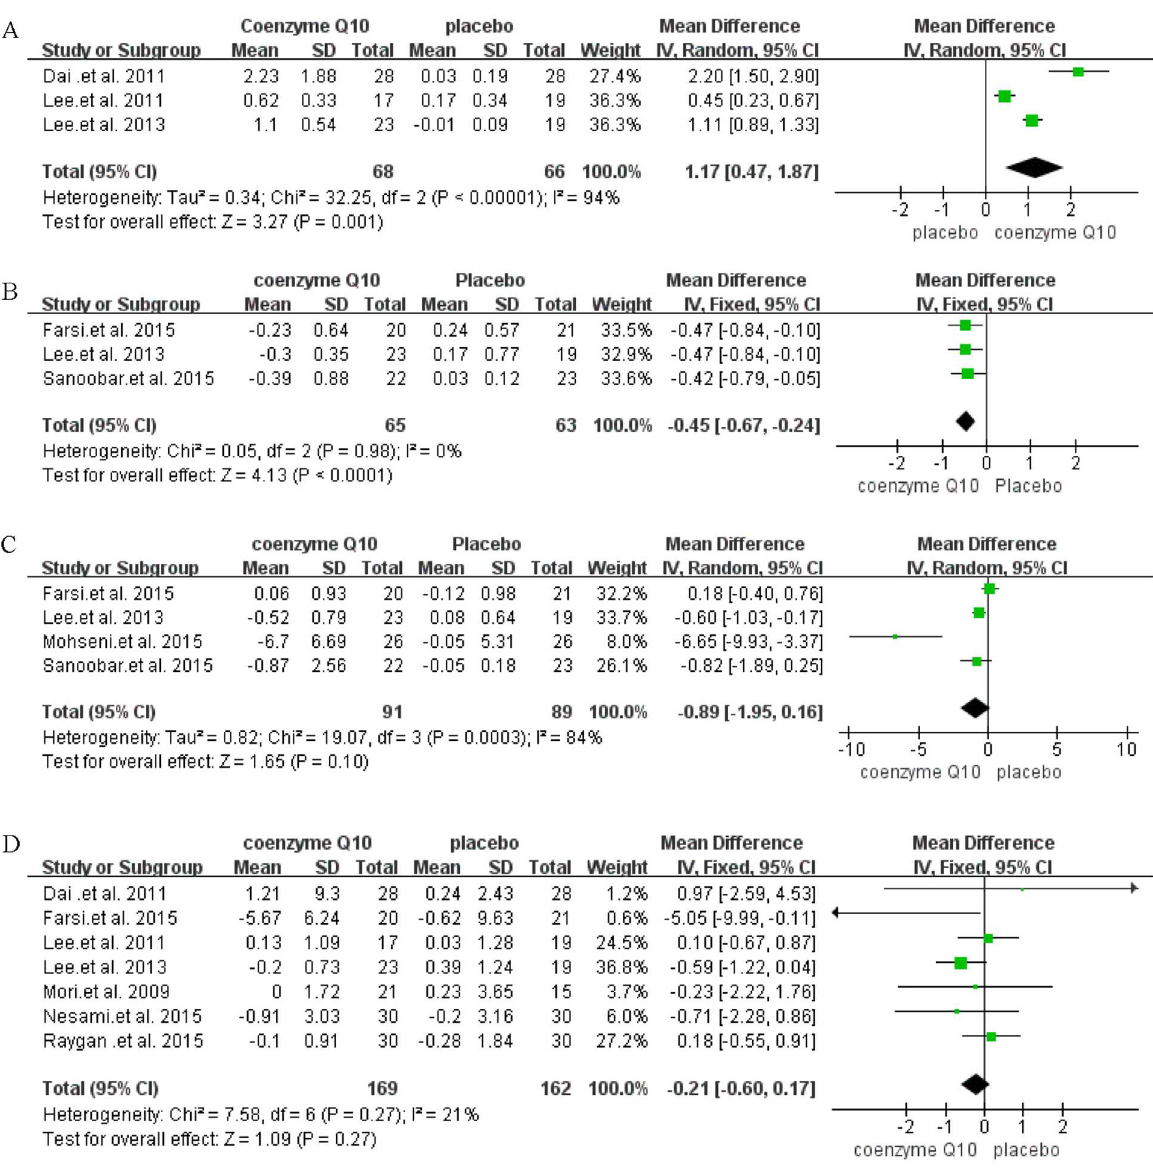
Fig 3. Forest plot of comparisons of Coenzyme Q10 supplementation versus placebo (outcomes: A: serum Coenzyme Q10, B: tumor necrosis factor-alpha, C: interleukin-6, D: C reactiveprotein).